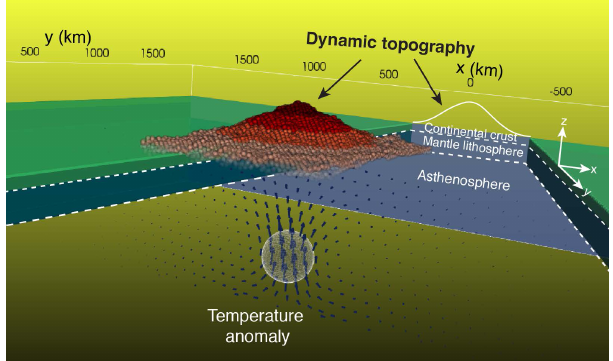
Figure 2. Three-dimensional numerical model of a spherical tem- perature anomaly having 96km radius and a density of 1% less dense than the ambient mantle embedded in a depth of 372km. The model space is 3840km long in x and y axes, and 576km deep along the z axis. The dynamic topography is depicted as an exag- gerated surface on the top of the model and is also reflected on the x − z